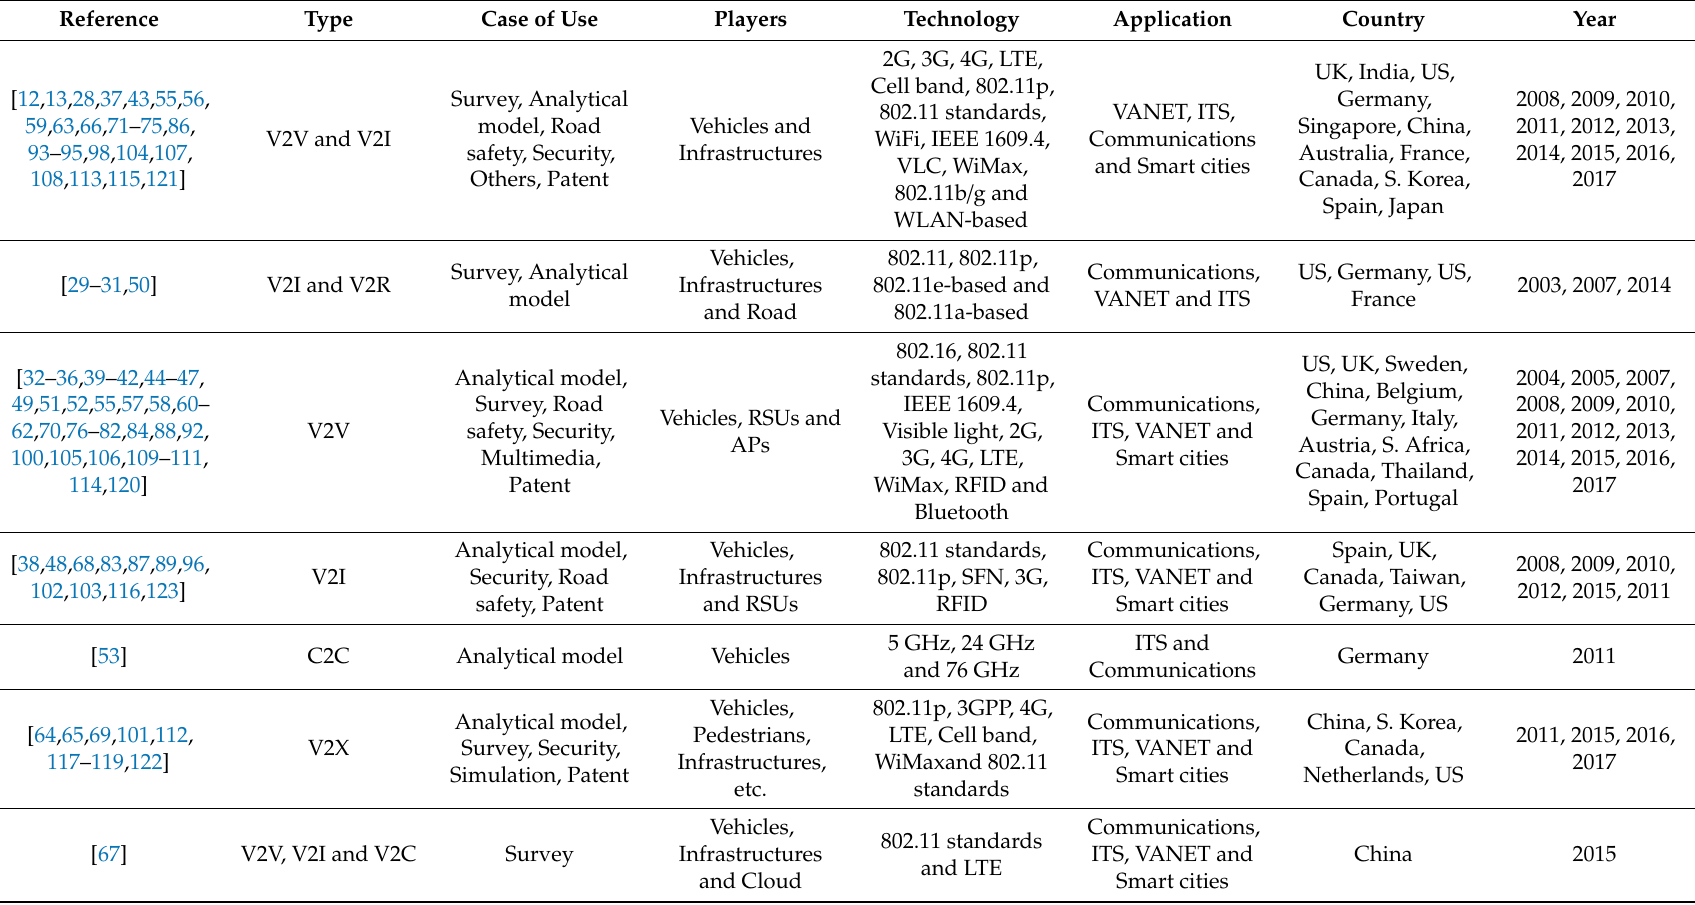
Table A1. Technological profile of the 100 most cited publications in the